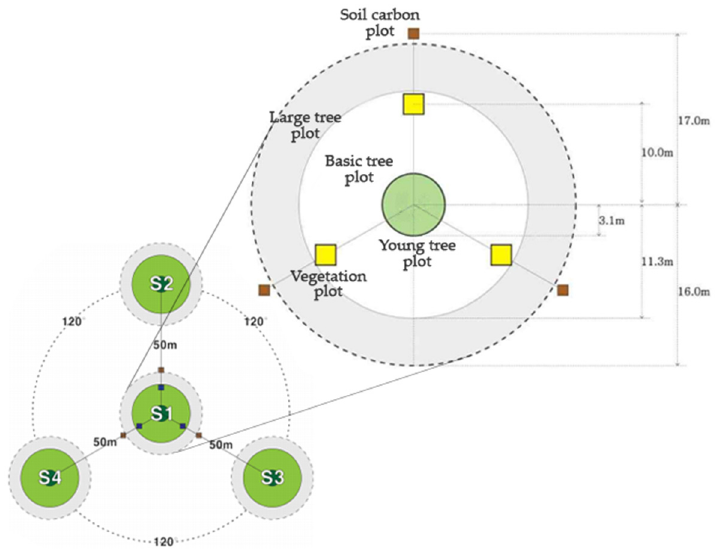
Figure 1. Plot design (NFI)